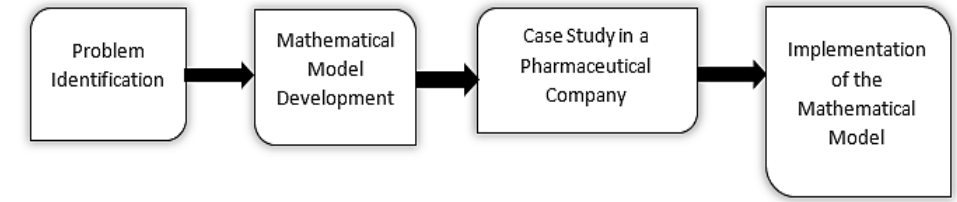
Fig. 1. Steps of research methodology.